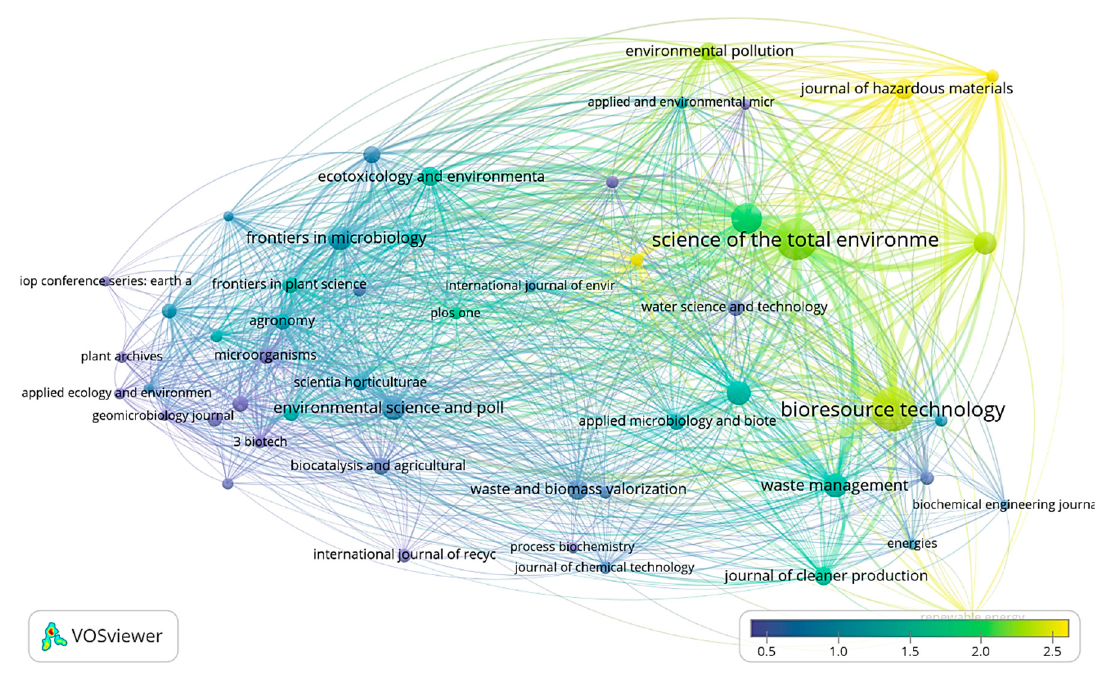
Figure 8. Tracking the journals that are involved in intensive fertilizer-based research and their rel- ative impact